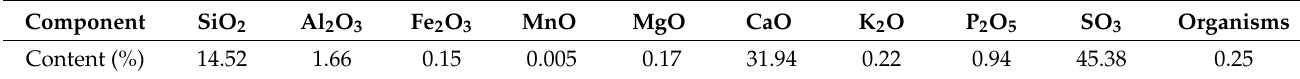
Table 1. Chemical content analysis of phosphogypsum.